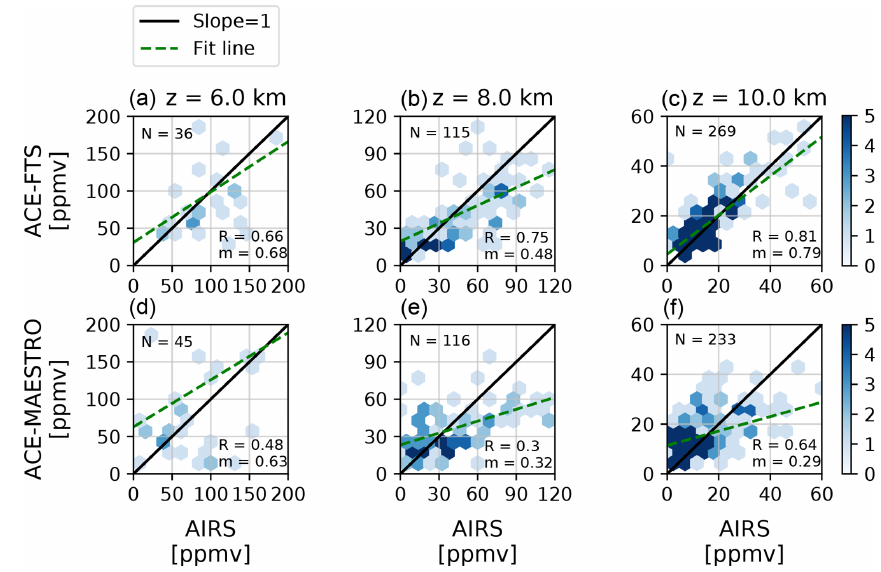
Figure 12. Same as Fig. 10, but with correlation plots for the ACE-FTS and ACE-MAESTRO vs. the AIRS satellite measurements.